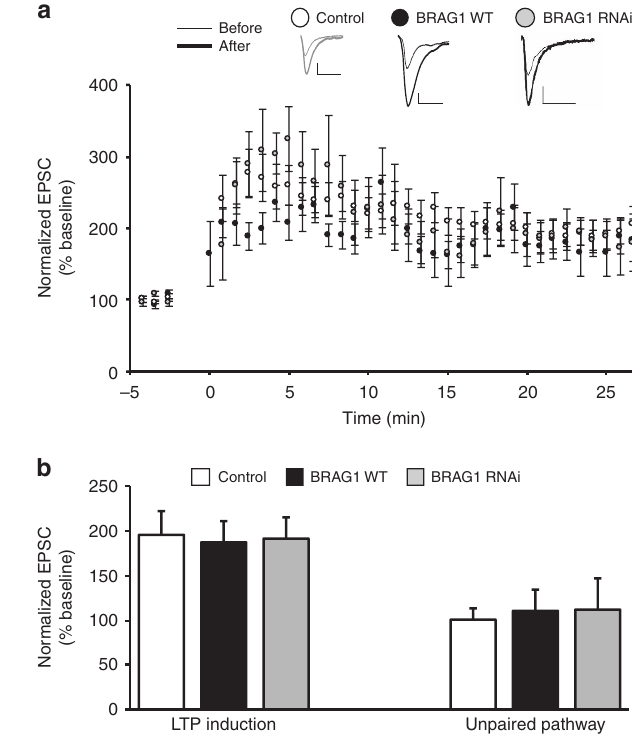
Figure 9 | BRAG1 is not required for LTP. ( a ) LTP was induced by pairing 3Hz presynaptic stimulation (300 pulses) with 0mV postsynaptic depolarization (indicated by an arrow) in CA1 neurons while expressing BRAG1 (black circles, n ¼ 7, P ¼ 0.96), BRAG1 RNAi (grey circles, n ¼ 5, P ¼ 0.86) or untransfected neurons (white circles, n ¼ 19). Insets: sample traces of evoked AMPAR-mediate responses recorded at (cid:2) 60mV before pairing (thin line) and 20min after pairing (thick line) from control or transfected cells as indicated. Scale bars, 20pA, 20ms. ( b ) Normalized averaged steady-state AMPAR-mediated responses in paired (LTP induction) and control (unpaired